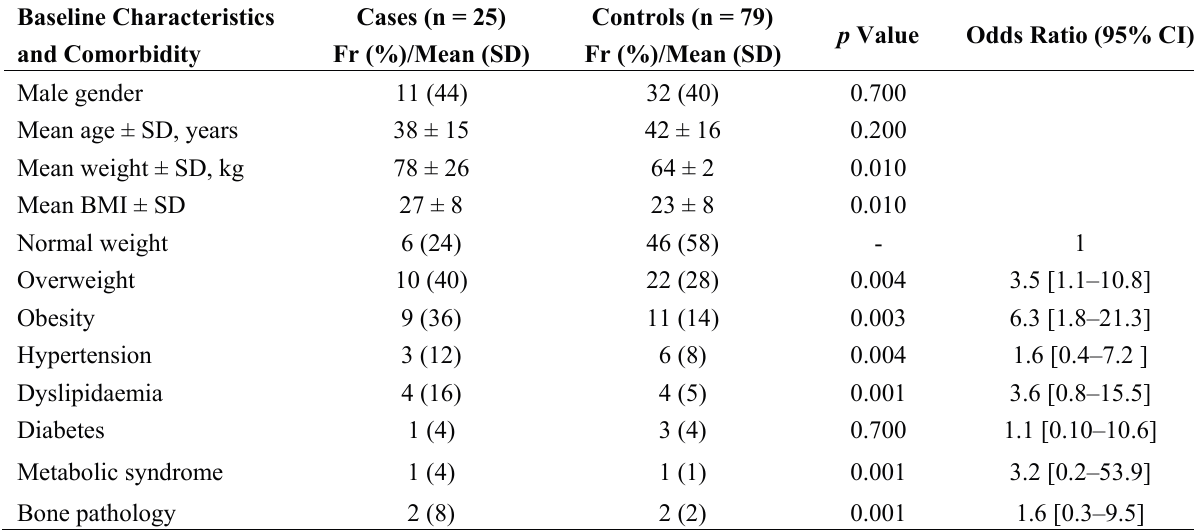
Table 1. Baseline characteristics and comorbidity of subjects with and without psoriasis.